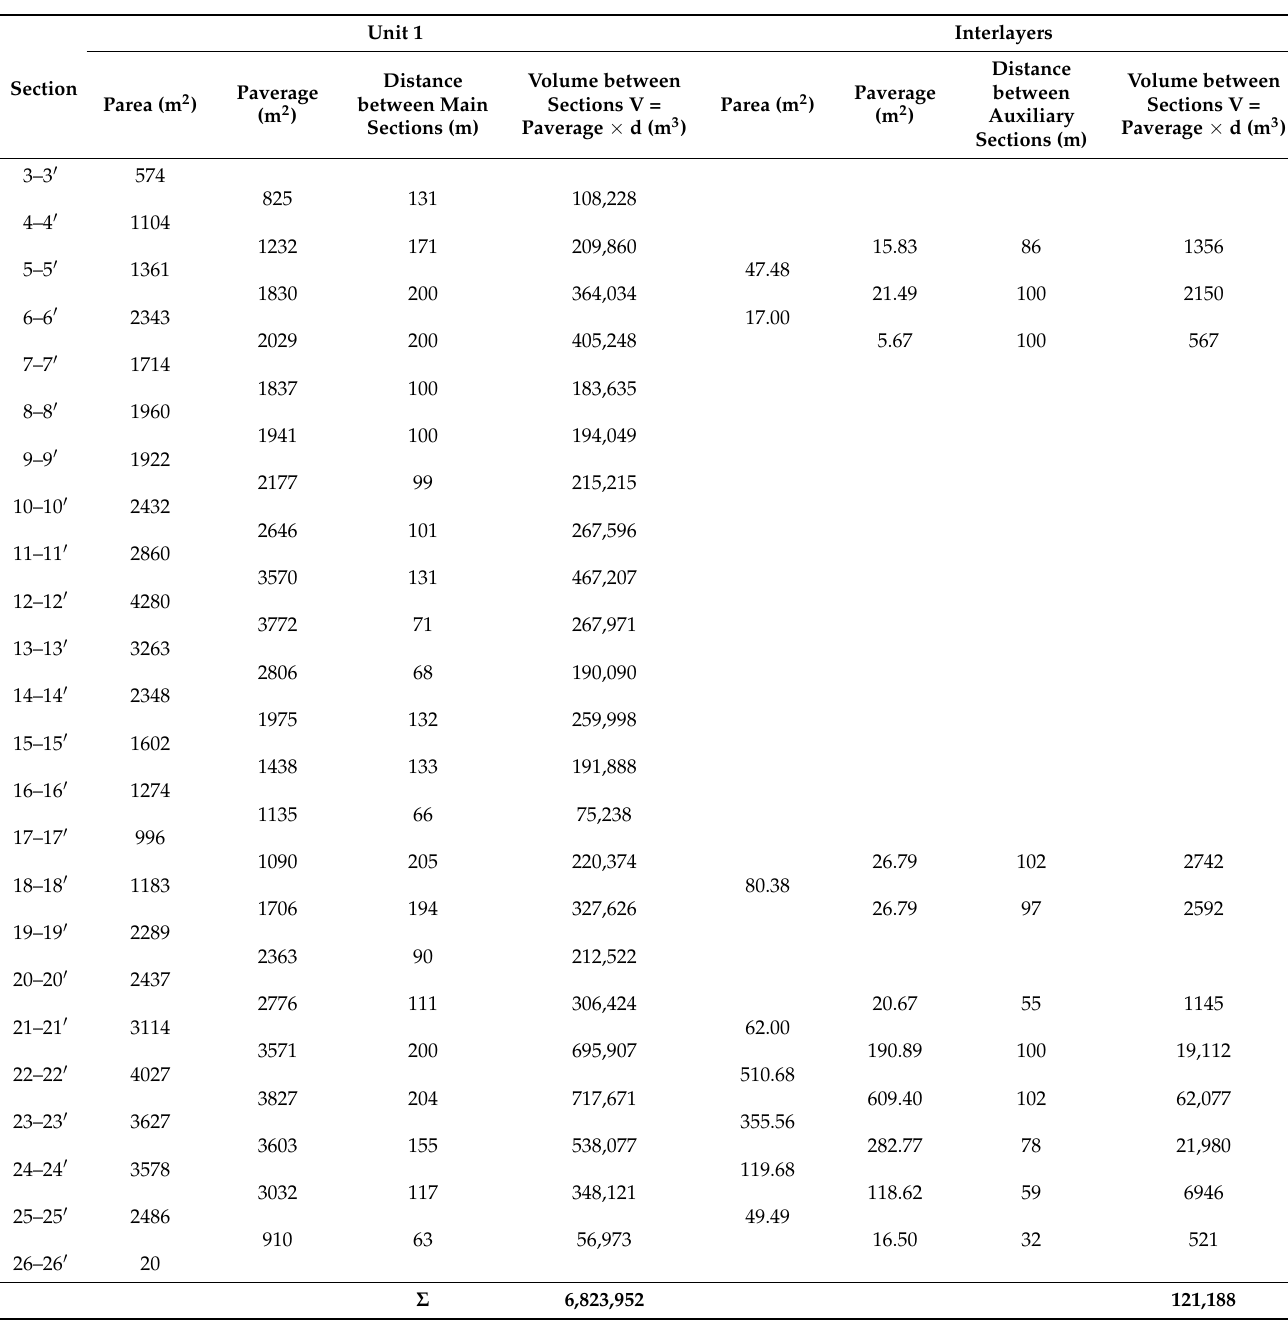
Table 1. Reserve of the unit 1 calculated using geological